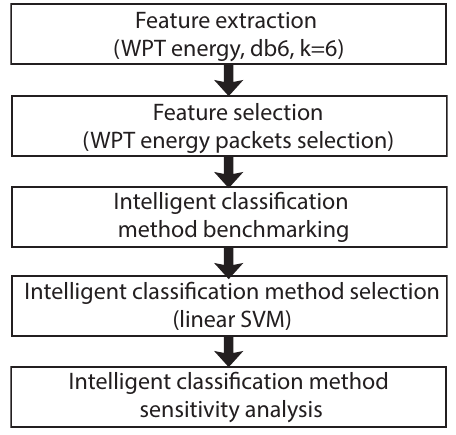
Figure 3. Overall methodology flow